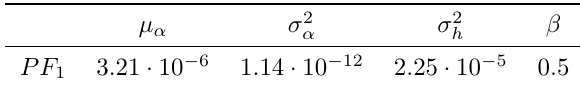
with marked part as 1 converges. α